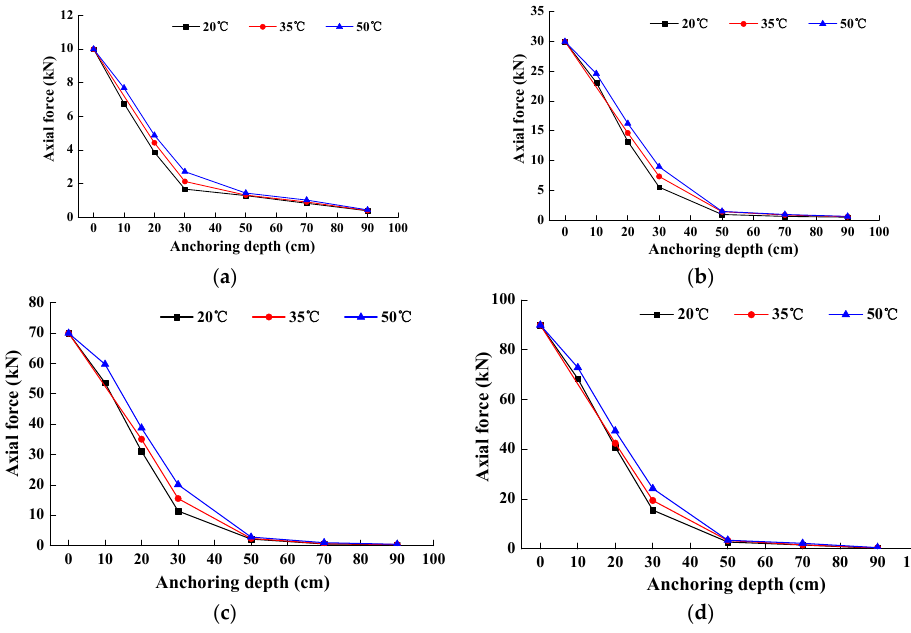
Figure 9. The distribution diagrams of axial force under different tensile force. ( a ) Tensile force is 10 kN. ( b ) Tensile force is 30 kN. ( c ) Tensile force is 70 kN. ( d ) Tensile force is 90 kN.